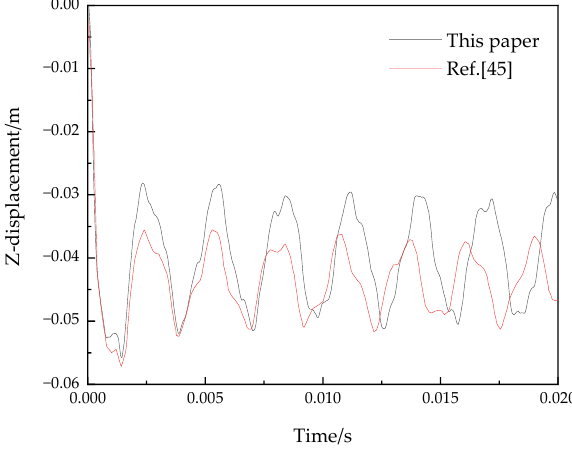
Figure 8. The central displacement time – history curve of circular plate.